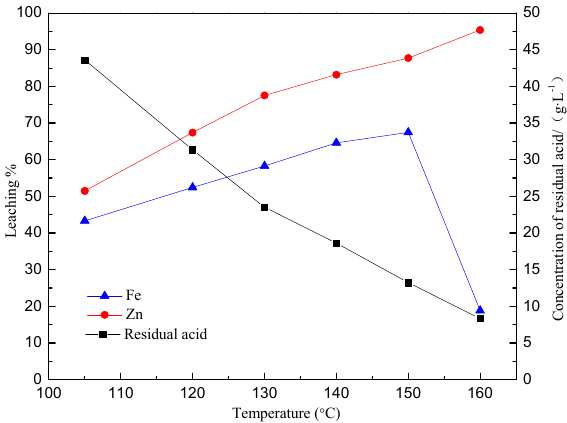
Figure 3. Effect of the leaching temperature on the extractions of Zn and Fe. Figure 3. E ff ect of the leaching temperature on the extractions of Zn and Fe.